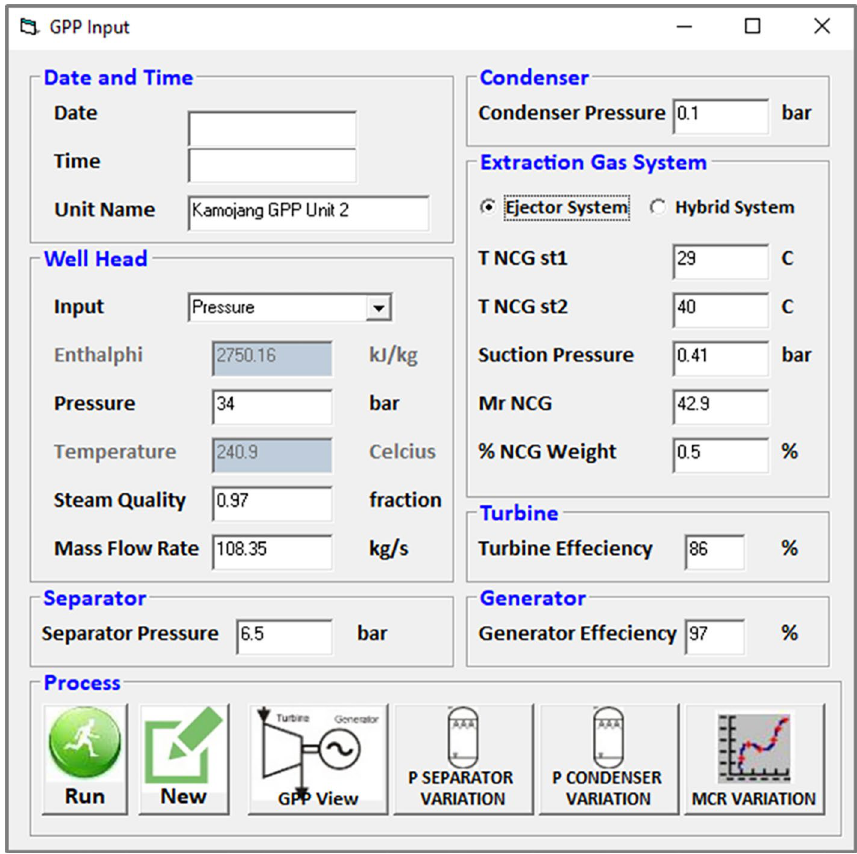
Fig. 13 An input interface of the single-flash Kamojang